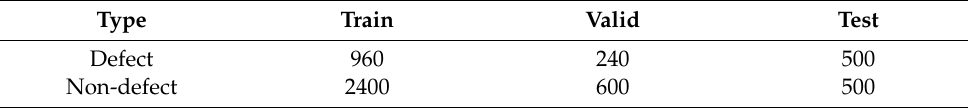
Table 3. Number of collected bearing datasets.